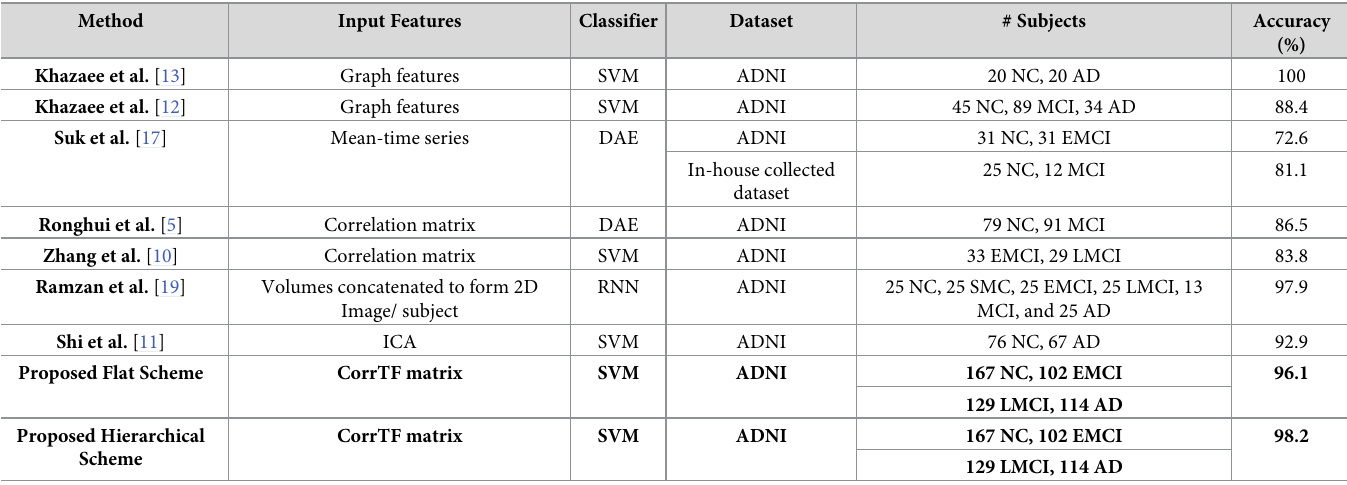
Table 6. Comparison with recently published work using ADNI dataset.